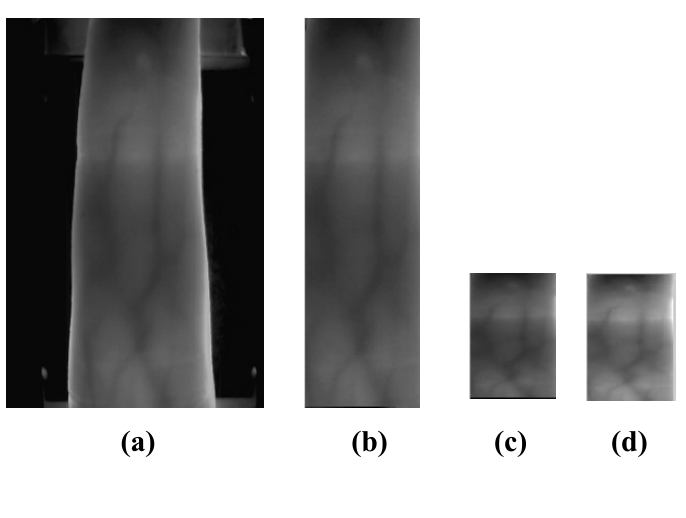
Figure 4. Examples of